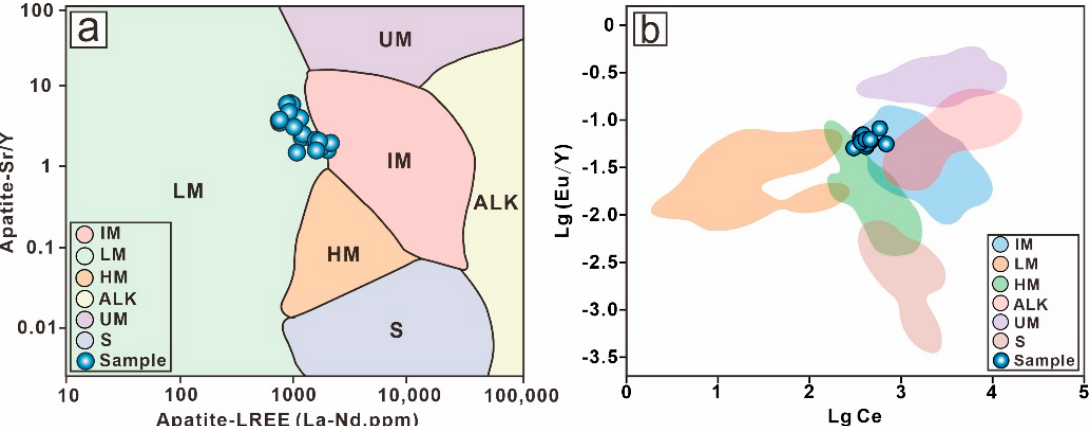
Figure 7. Diagrams showing apatite trace element composition. Apatites plotted on a support vector machine apatite classification biplot ( a ) and a Eu/Y vs. Ce discrimination diagram of apatite [83,84] ( b ) . Abbreviations: ALK—alkali-rich igneous rocks; HM—partial melts/leucosomes/high-grade metamorphic rocks; IM—mafic I-type granitoids and mafic igneous rocks; LM—low- and medium- grade metamorphic and metasomatic rocks; S—S-type granitoids and high aluminum saturation index (ASI) ‘felsic’ I-types; UM—ultramafic rocks including carbonatites, lherzolites, and pyroxenites.